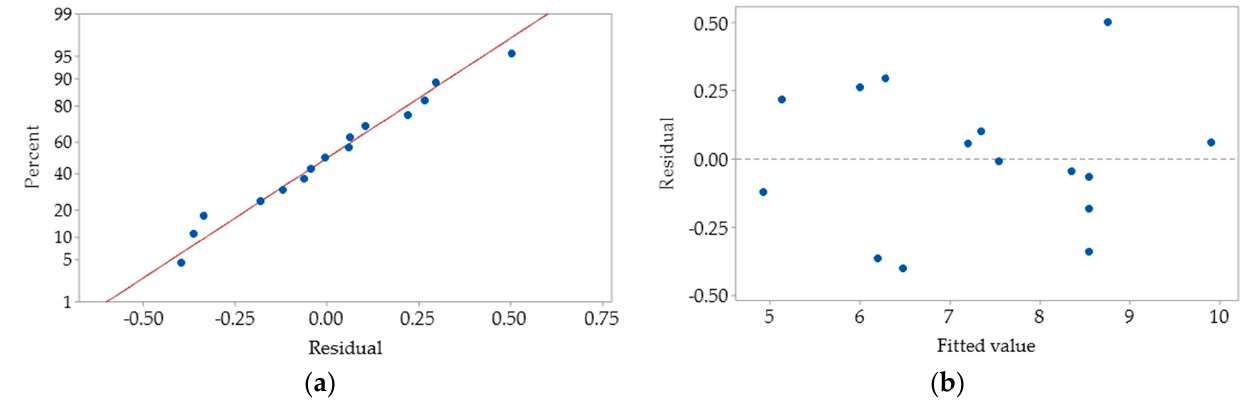
Figure 2. Normal probability plot ( a ) and versus fits plot ( b ) for moisture content of the PSPP (%).